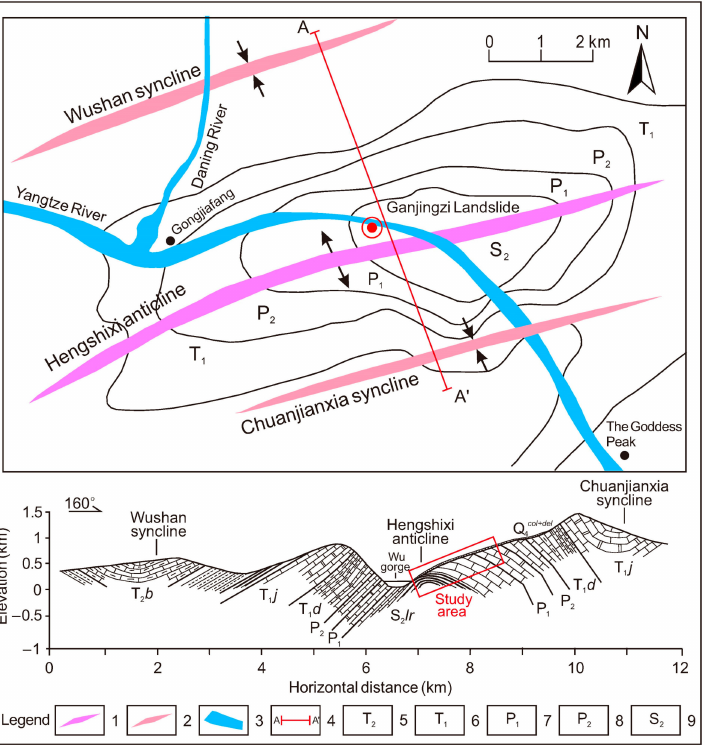
Figure 2. Tectonic background of the study area: ( 1 ) anticline, ( 2 ) syncline, ( 3 ) the Yangtze River, ( 4 ) cross section, ( 5 ) Middle Triassic strata, ( 6 ) Lower Triassic strata, ( 7 ) Lower Permian strata, ( 8 ) Upper Permian strata, and ( 9 ) Lower Silurian